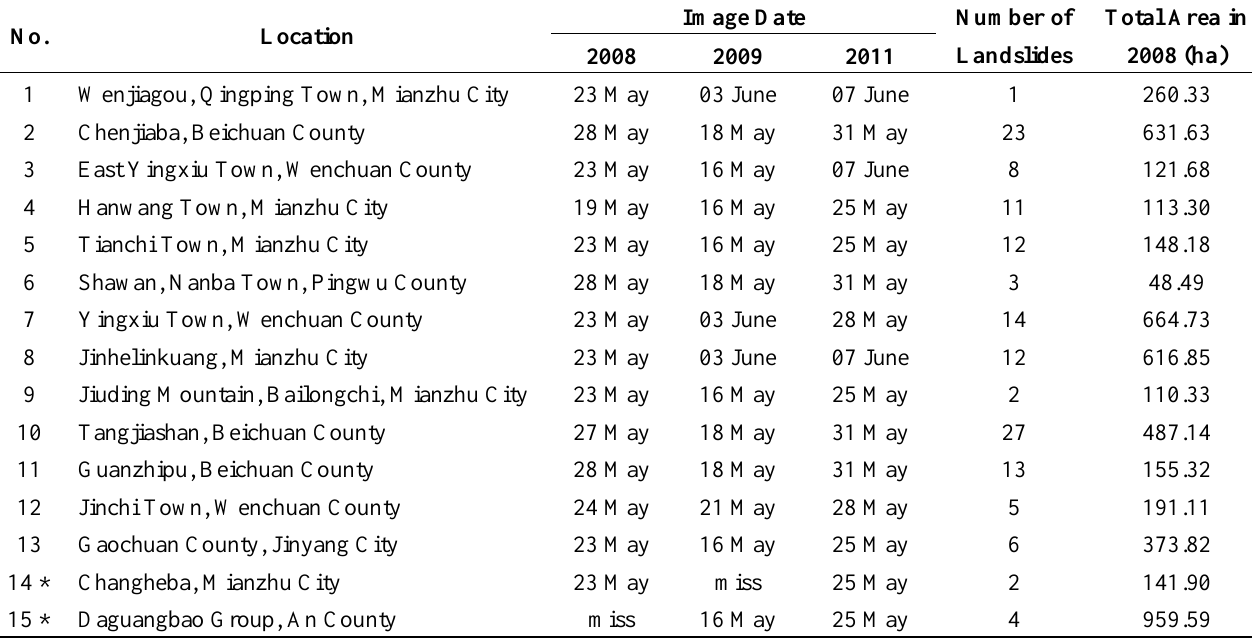
Table 2. Statistics for the 15 geologic hazard